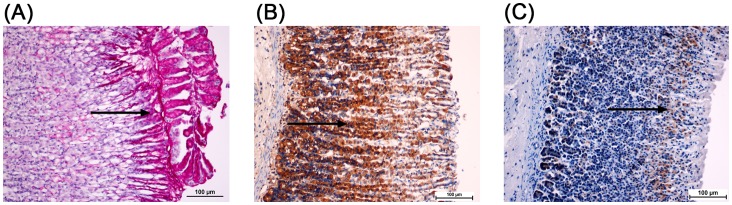
Glycoprotein-PAS staining and immunohistochemical evaluation for the expression of Hsp70 and Bax proteins of the gastric mucosa.Oral administration of the zinc (II) complex (2.181×10−5 M/kg) increased the glycoprotein content of the gastric tissue (A), enhanced the expression of Hsp70 protein (B) and suppress the expression of Bax protein (C). The arrows point to the respective protein accumulations.